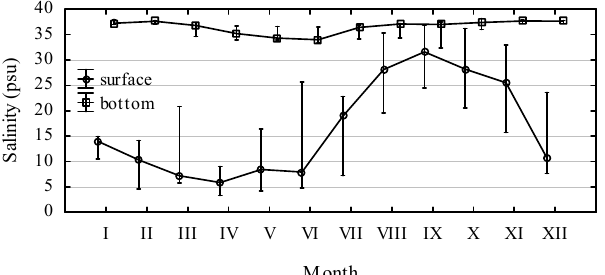
Figure 1. Difference between the surface and the bottom (10 m) salinity at central Adriatic Sea stations SI1 – SI5 with mean monthly values; bars indicate min. and max. values for the 3-year investigation period